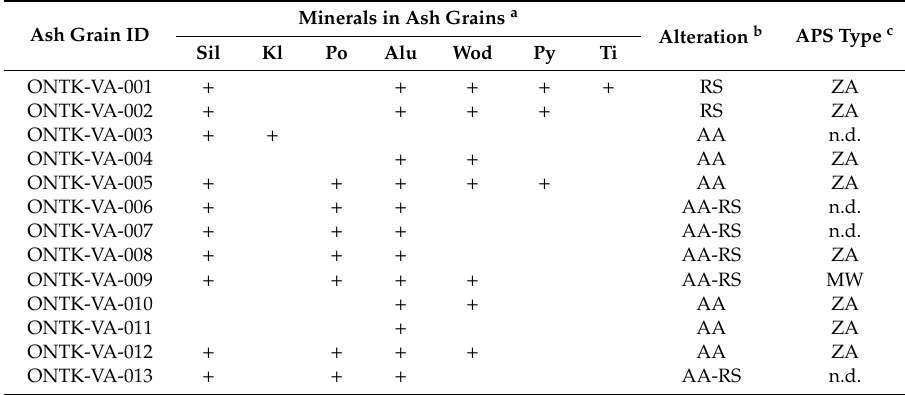
Table 2. Summary of petrographical observation on volcanic ash